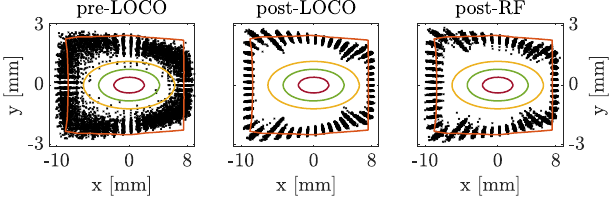
FIG. 16. On-energy dynamic aperture at different stages of commissioning. Plotted are individual error sets (black) and the dynamic aperture for the ideal lattice including the aperture (red) before linear optics correction (left), after optics correction (center), and the final result after adjusting the rf frequency (right). The colored ellipses indicate the beam size of the injected beam ( 1 σ , 2 σ , and 3 σ